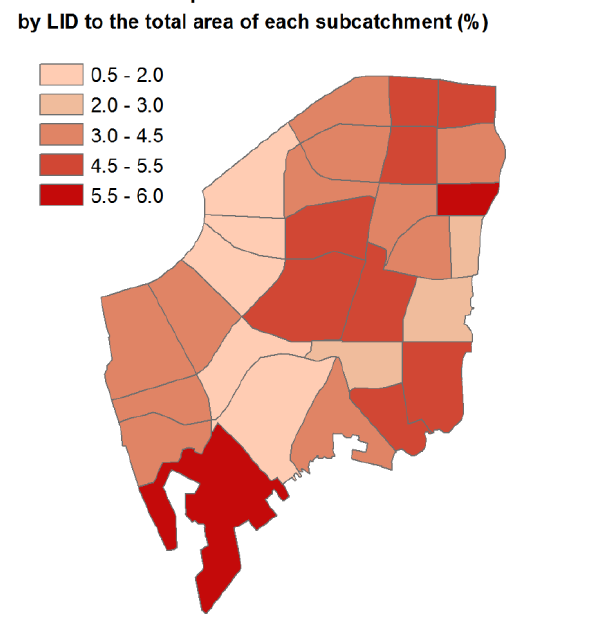
Figure 7. The low impact development (LID) implementation intensity in each subcatchment under Scenario 1.